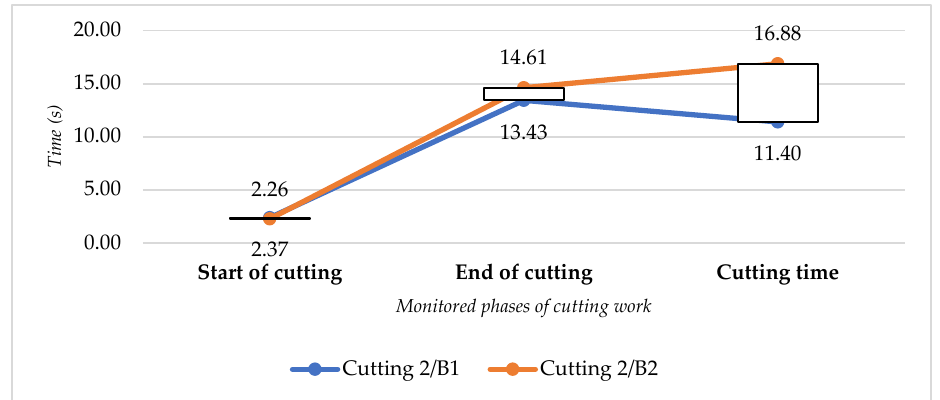
Figure 12. Summary of results (average) for the observed phases concerning the type “B” pillar cutting process.